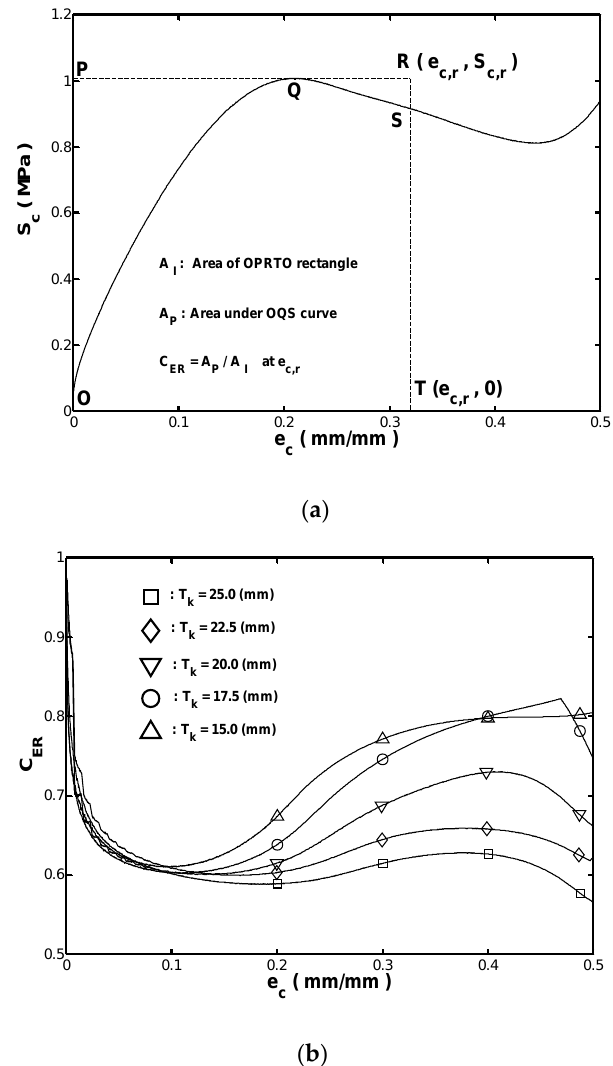
Figure 5. ( a ) Illustration of proposed energy-effectiveness index 𝐶 𝐸𝑅 ; ( b ) Variation of 𝐶 𝐸𝑅 with compressive strain 𝑒 𝑐 for fenders with different wall thicknesses.